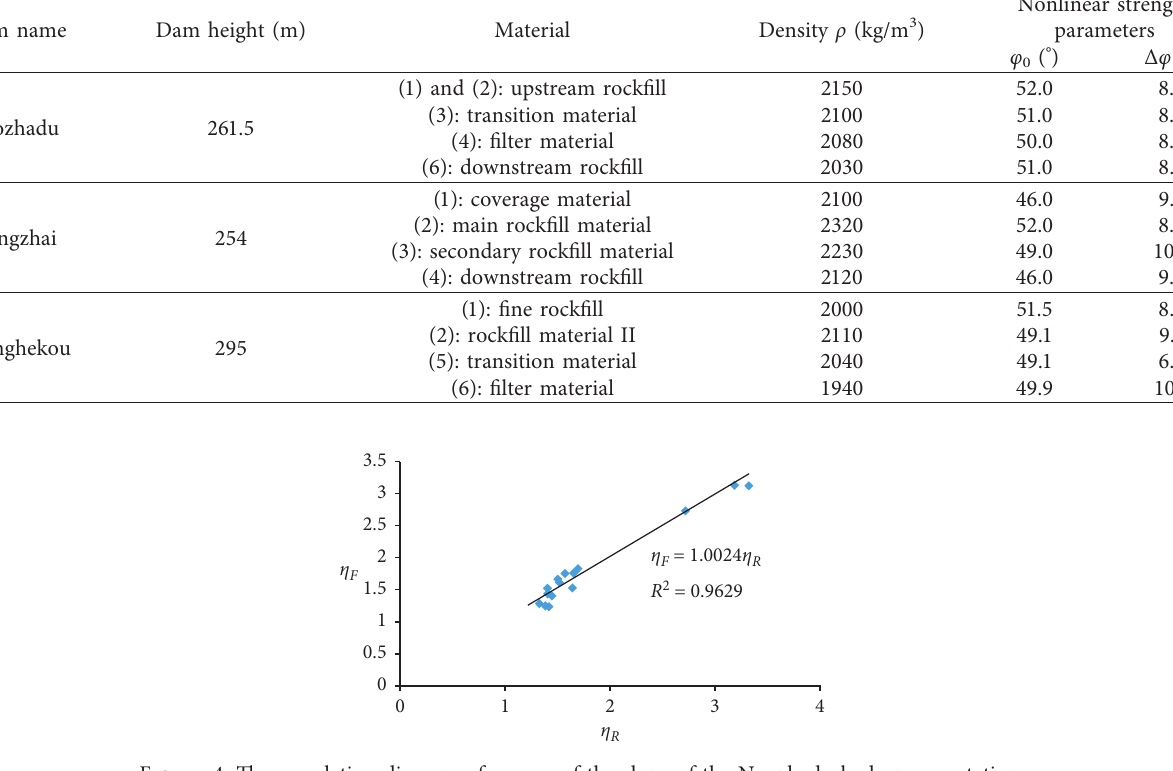
Table 7: Statistical parameters of the three ultrahigh dams in China with heights of more than 200 m.